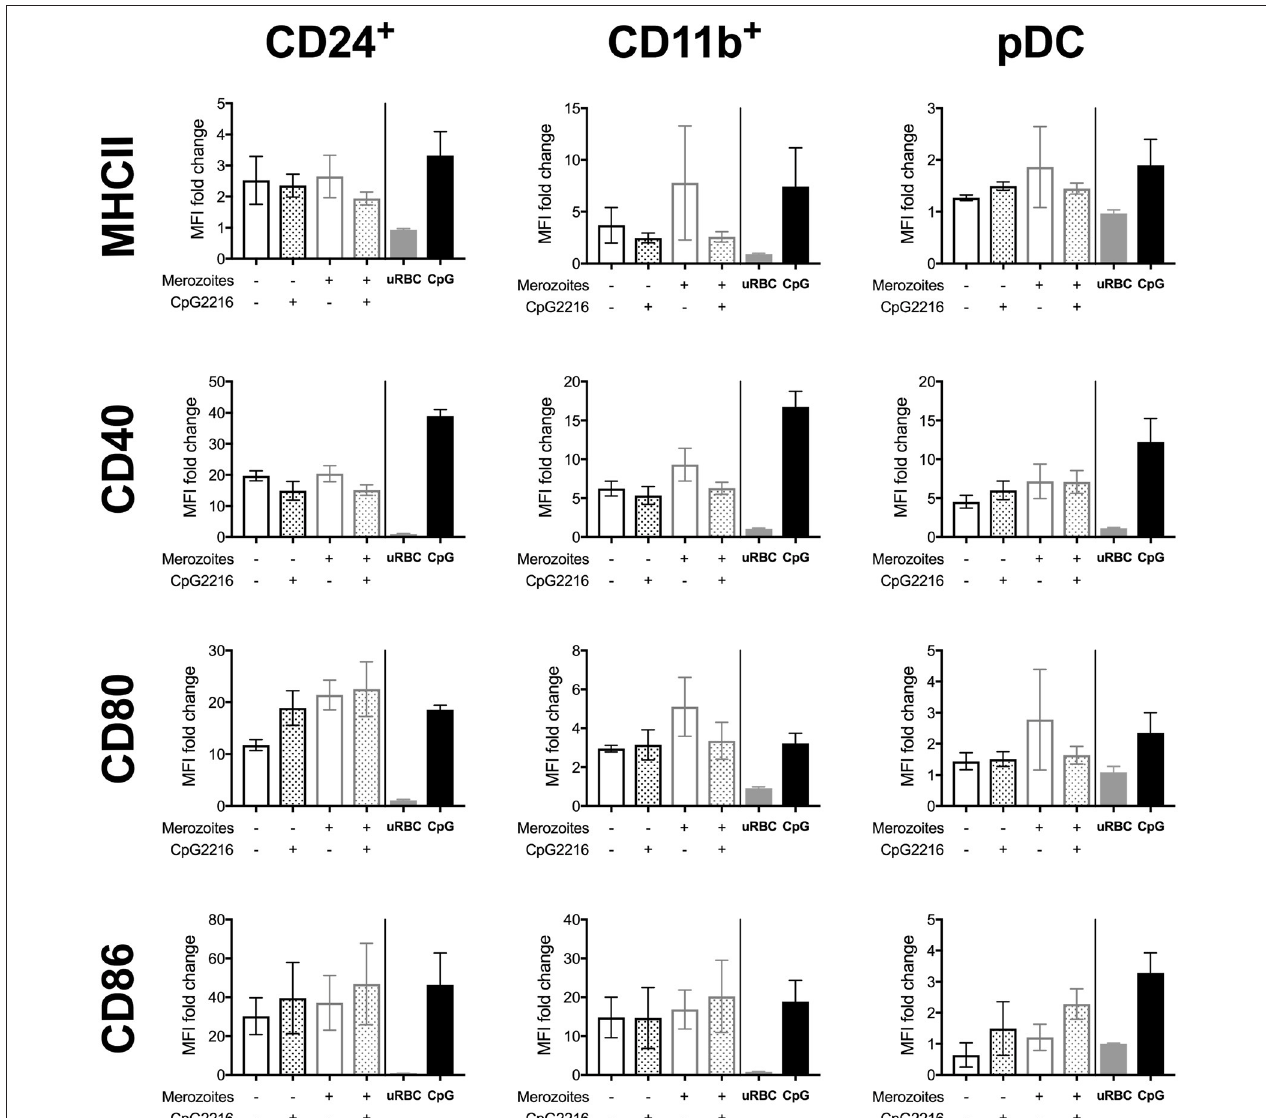
FIGURE 6 | Stimulation with mixed high-dose pRBCs and merozoites in the presence or absence of CpG2216 does not result in recovery of CD40 expression. FL-DCs were stimulated with either pRBCs alone, or pRBCs in the presence of an equivalent ratio of merozoites (Mz), in the presence or absence of CpG2216. All pRBCs and merozoites were added at a ratio of 25 per DC. Neither the addition of merozoites nor the addition of CpG2216 resulted in rescue of CD40 expression, but other markers demonstrated a heterogenous response. Co-stimulatory marker expression is represented as fold increase over media control and each bar represents mean and SEM of two experiments based on pooled FL-DC cultures of two